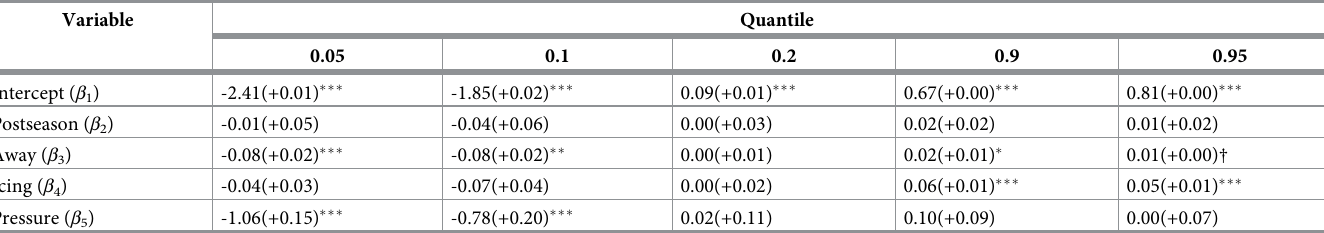
Table 3. Logistic quantile regression model of field goal (2000–2017).